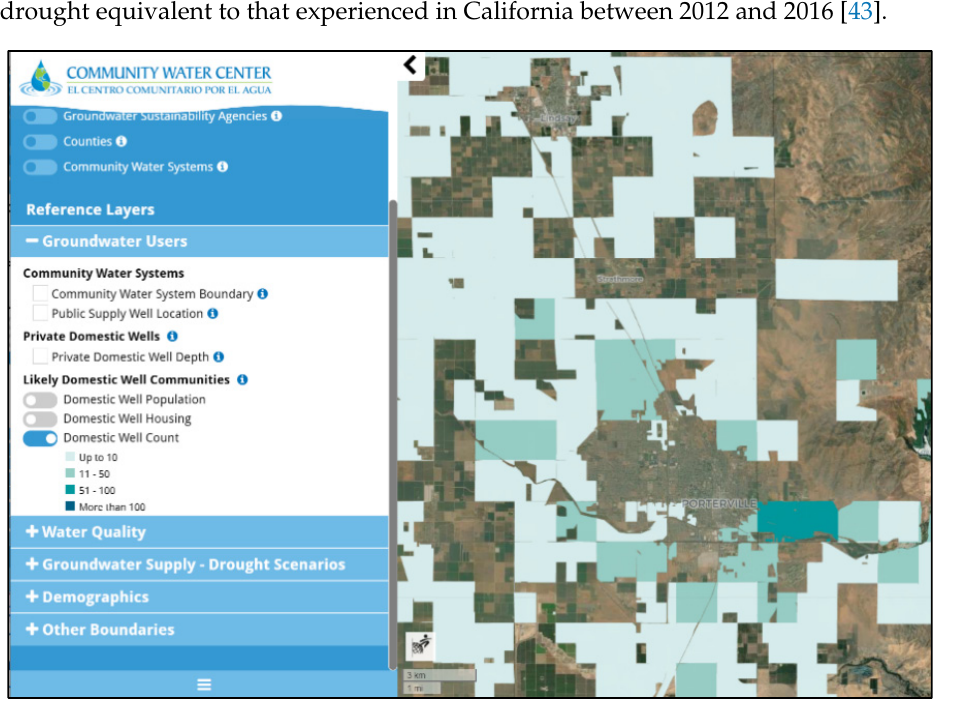
Figure 2. Screenshot of the Drinking Water Tool showing the Groundwater Users reference layer with the Likely Domestic Well Communities option set to Domestic Well Count for a particular region.